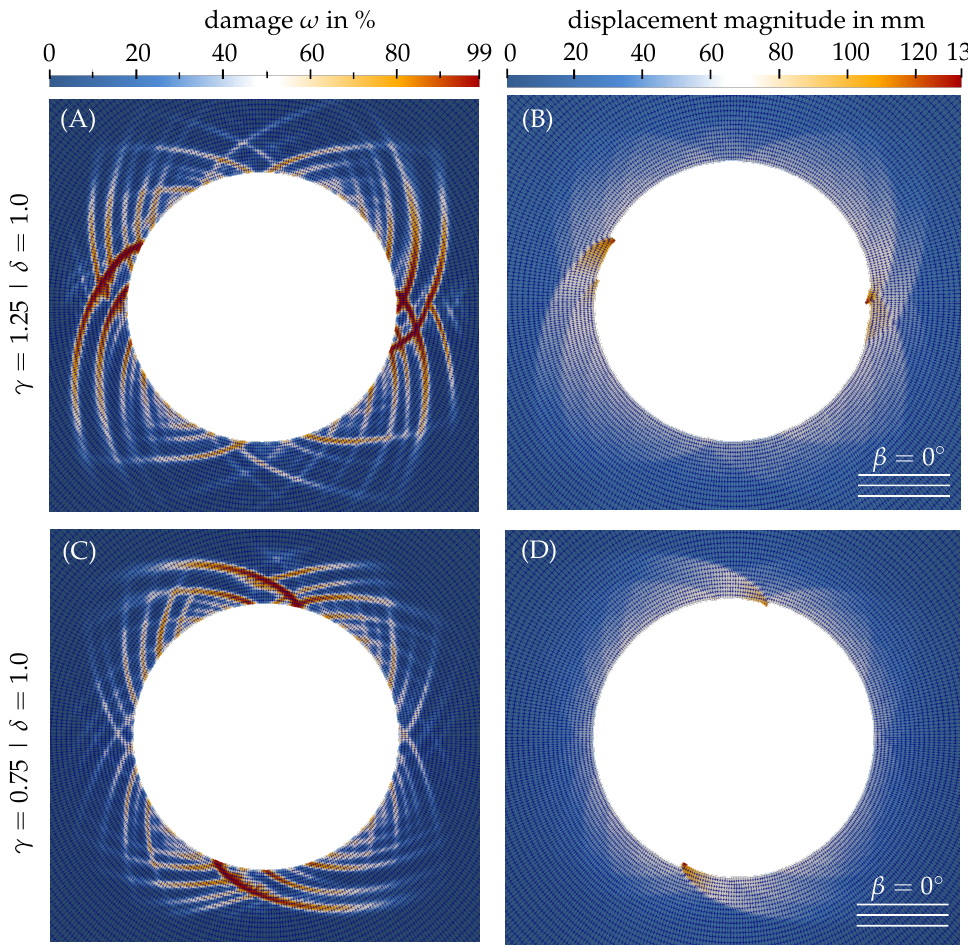
Figure 8. Distribution of the damage variable ω (left) and the displacement magnitude (right) (displacement scale factor 3) in the final stage of the tunnel simulation using the isotropic RDP model.